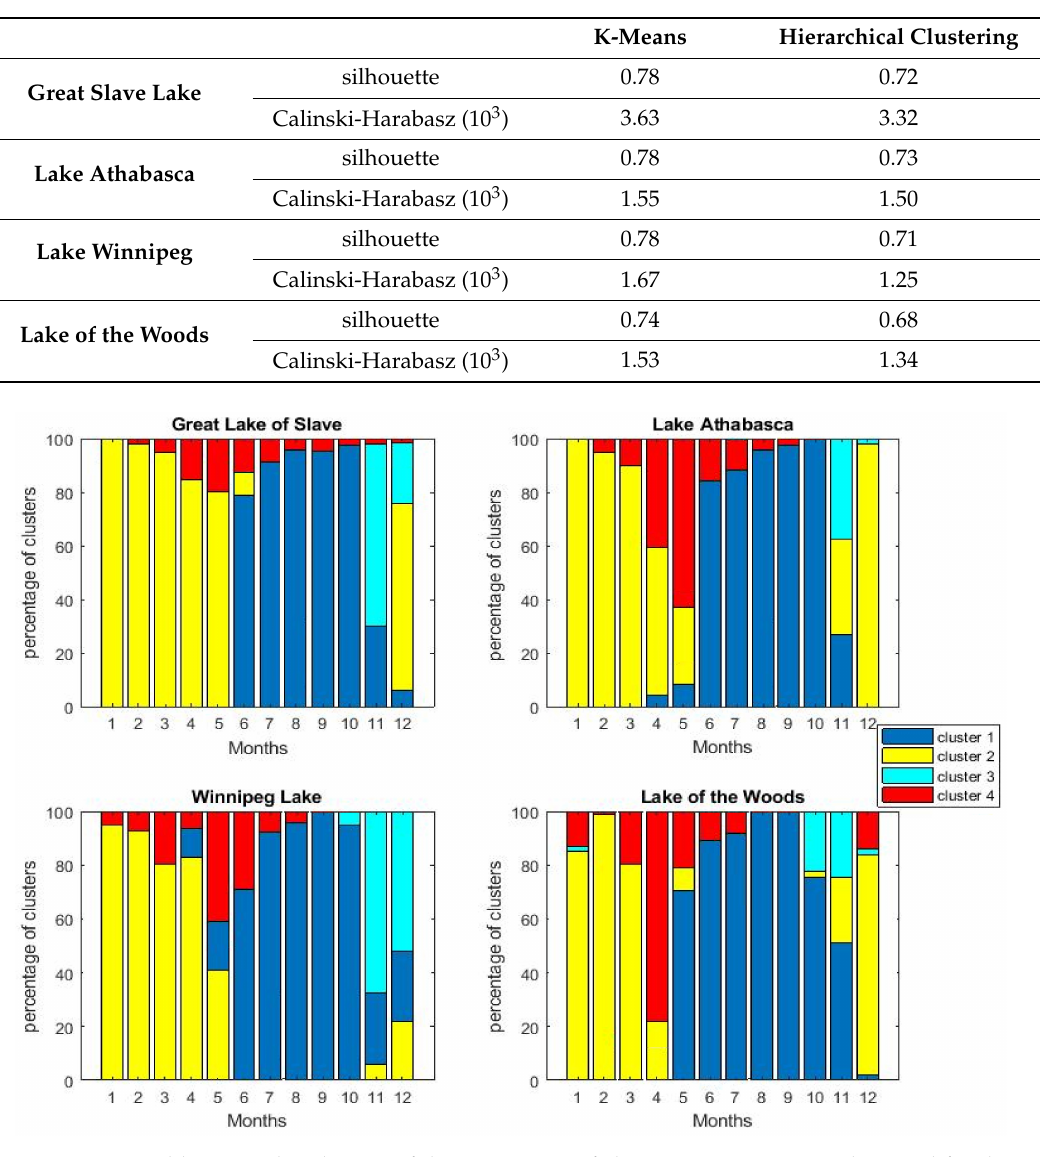
Figure 7. Monthly mean distribution of the percentage of clusters occurring in each period for the di ff erent lakes that were considered (cluster1: open water class; cluster 2: ice cover class; cluster 3: ice freeze-up class; and cluster 4: ice break-up